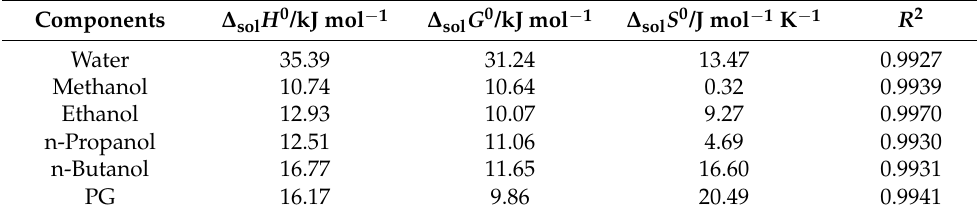
Table 12. Apparent thermodynamic parameters ( ∆ sol H 0 , ∆ sol G 0 , and ∆ sol S 0 ) and R 2 values for TRV in six different mono-solvents c . Components